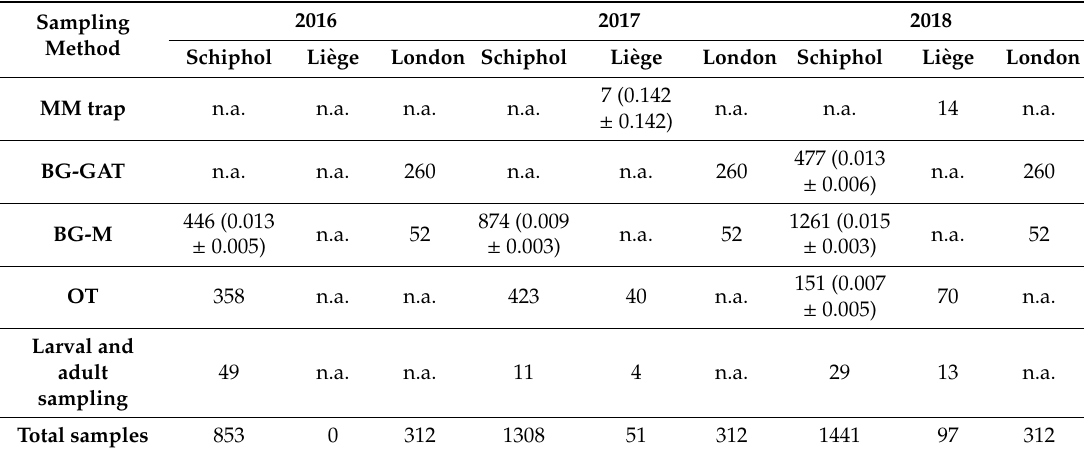
Table 2. Number of samples collected by sampling method at Schiphol (the Netherlands), Li è ge (Belgium) and London (Heathrow and Gatwick, United Kingdom) airports. n.a.: not applicable. Numbers in brackets represents the mean and standard error of samples containing EMS of each